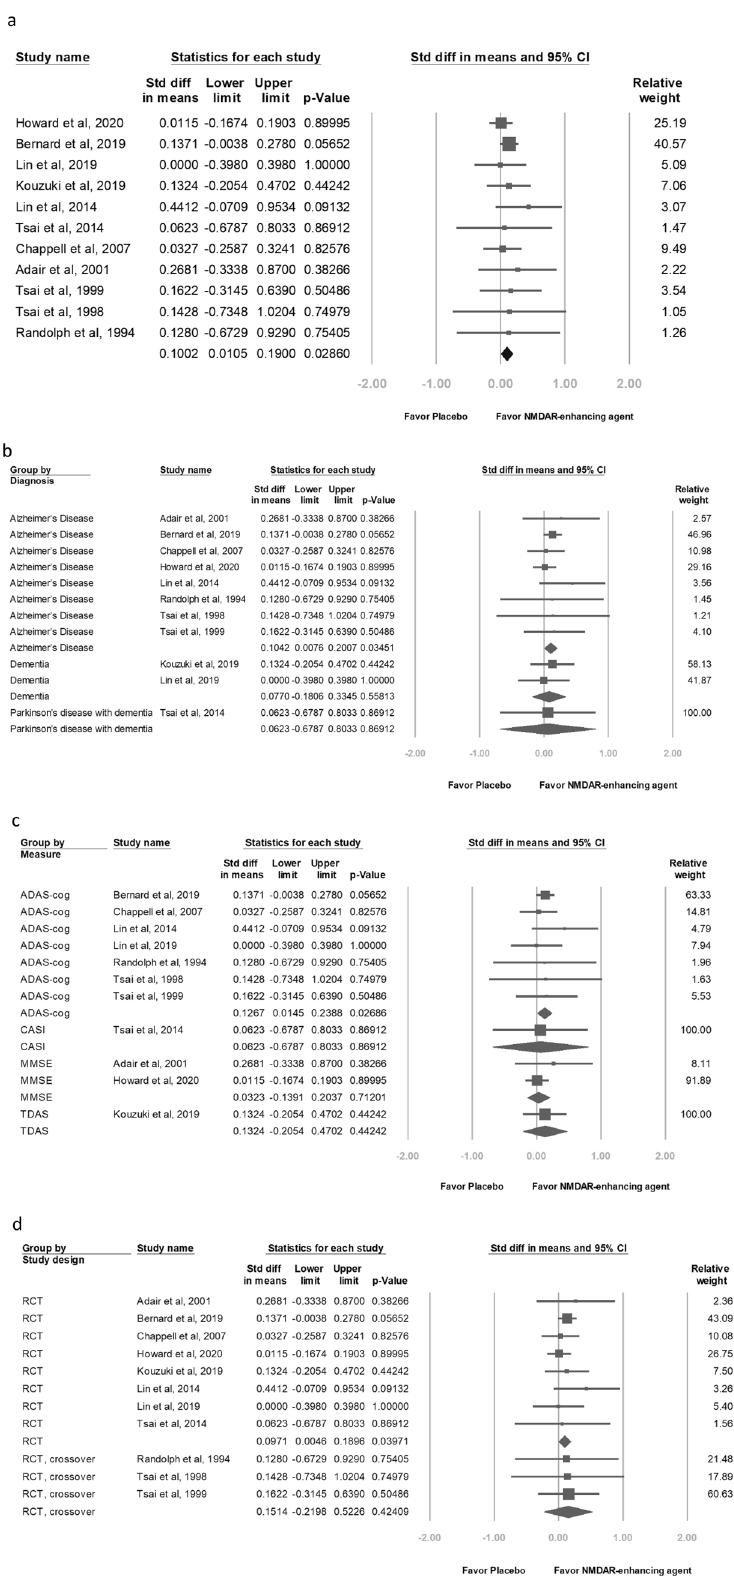
Figure 2. Meta-analyses of ( a ) overall cognitive function, ( b ) diagnosis of dementia groups, ( c ) cognitive measure groups, ( d ) study design groups, ( e ) NMDAR enhancing agent groups, ( f ) drug pathway in enhancing glutamatergic neurotransmission groups, ( g ) duration of therapy groups, and ( h ) age range